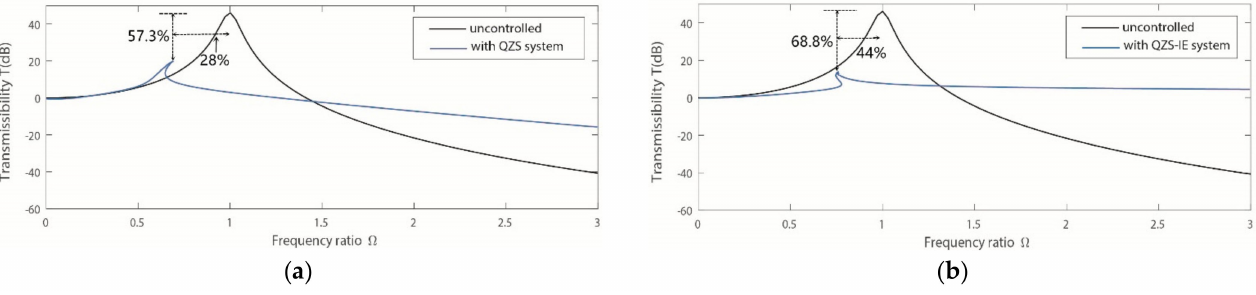
Figure 13. The vibration suppression effects of the seat suspension system ( u 0 = 0.4): ( a ) The displacement transmissibility of the QZS system without inerter elements; ( b ) the displacement transmissibility of the QZS-IE